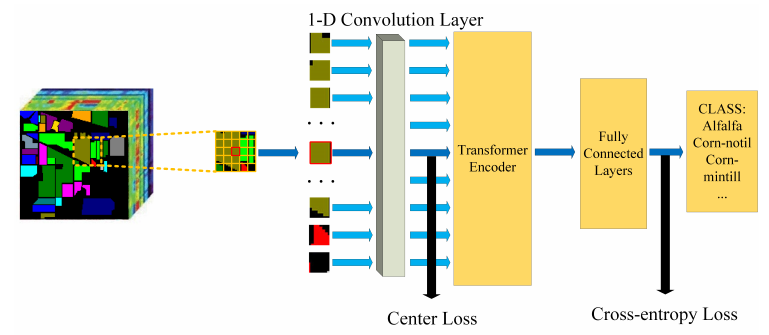
Figure 1. The overall architecture of our proposed